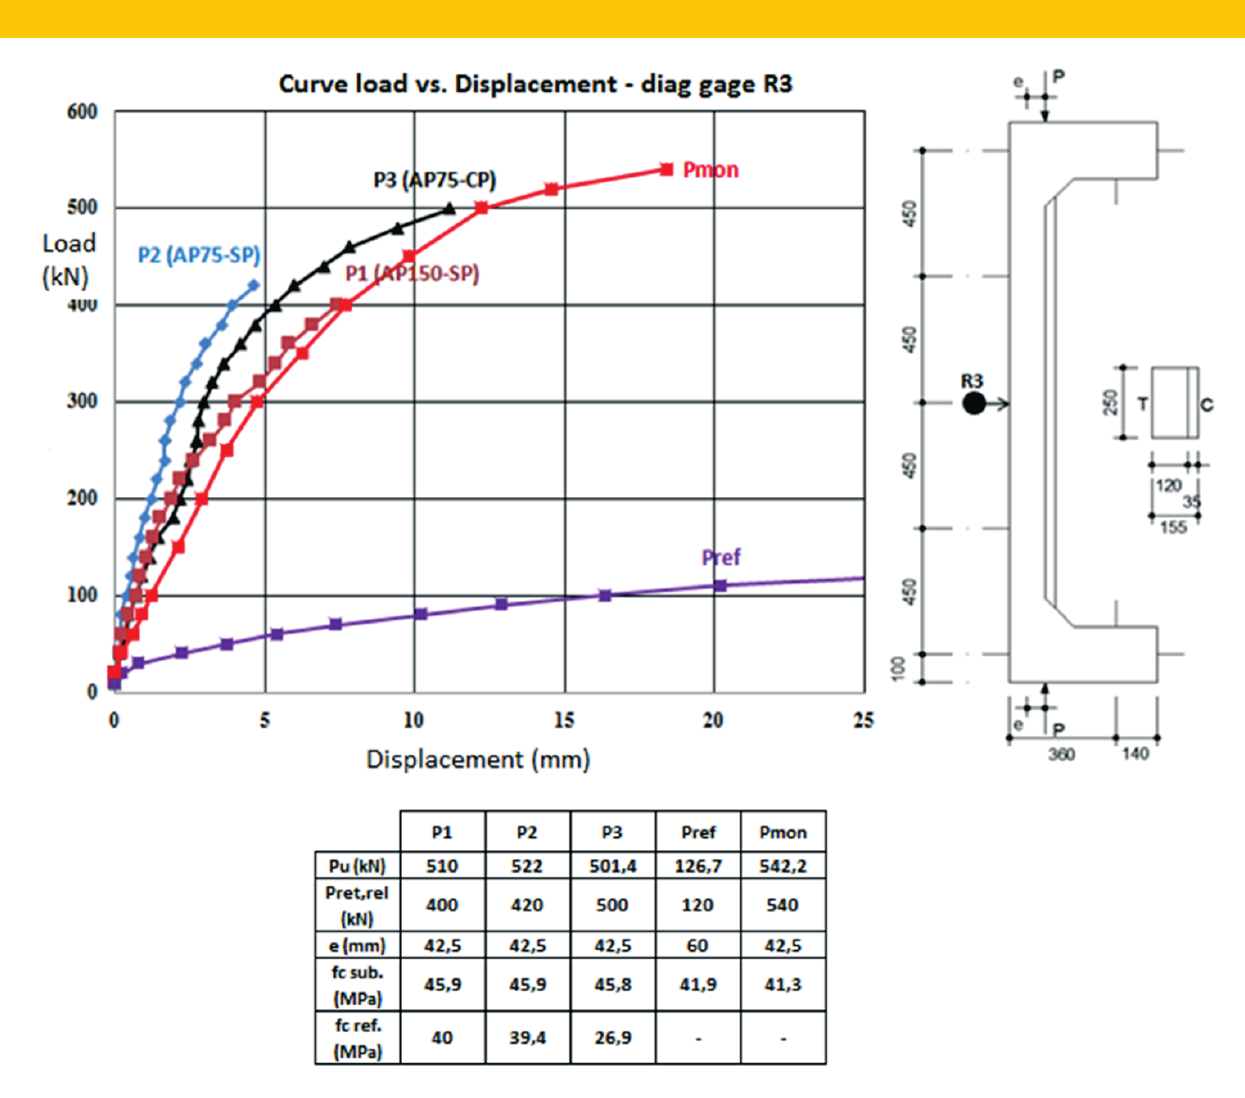
Figure 10 – Curve Load vs. Displacement, for dial gage